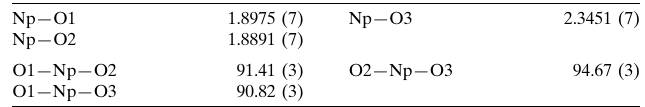
Selected geometric parameters (A˚ , (cid:3) ).